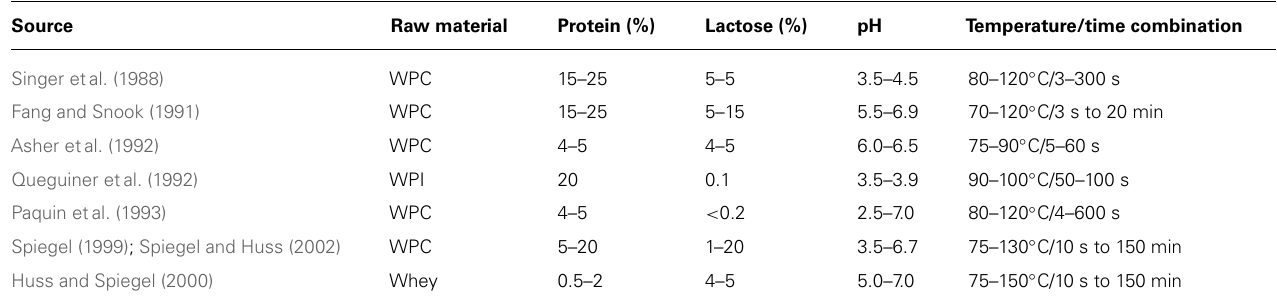
Table 3 |Applied heat treatments for whey and whey products. Source Raw